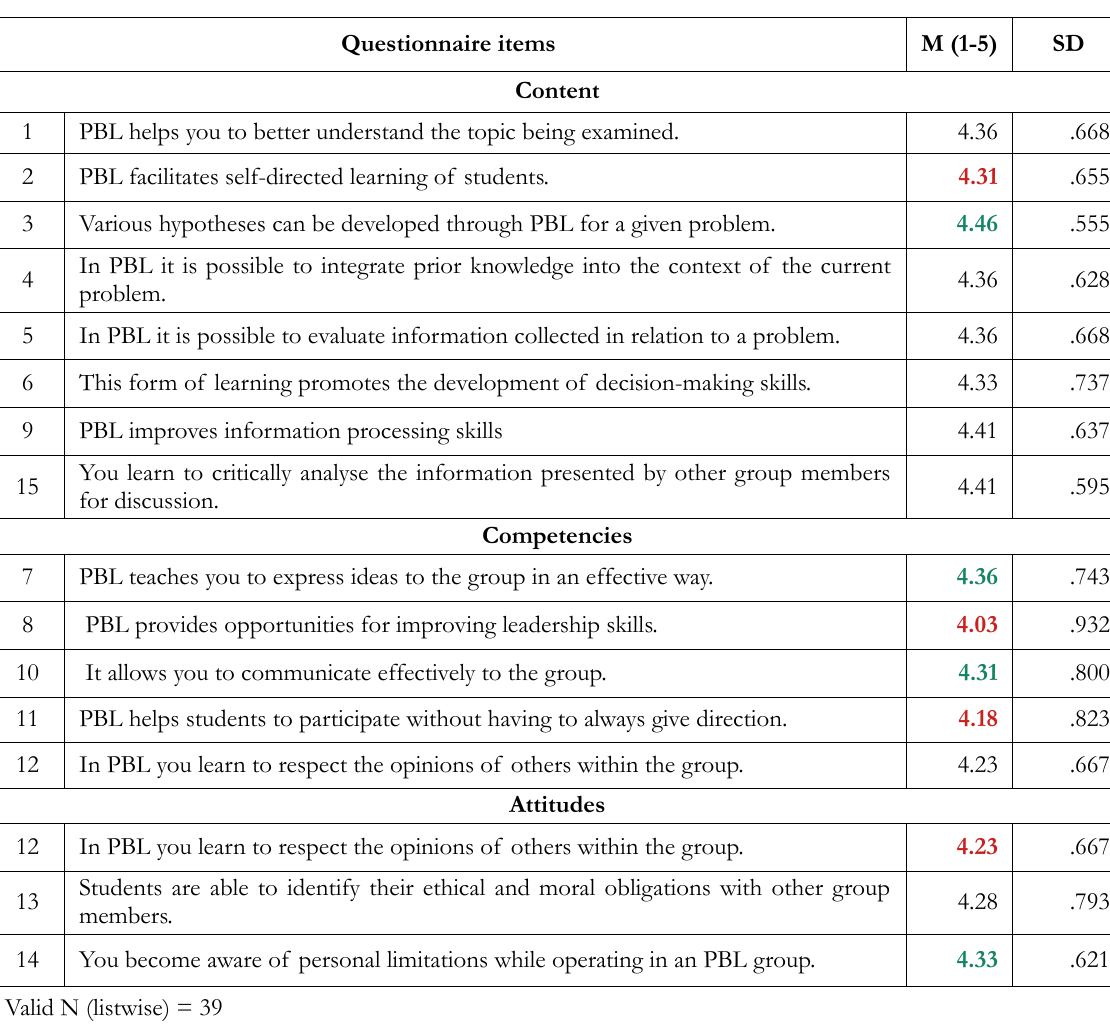
Table 5. CAPABP results (39 valid responses from the